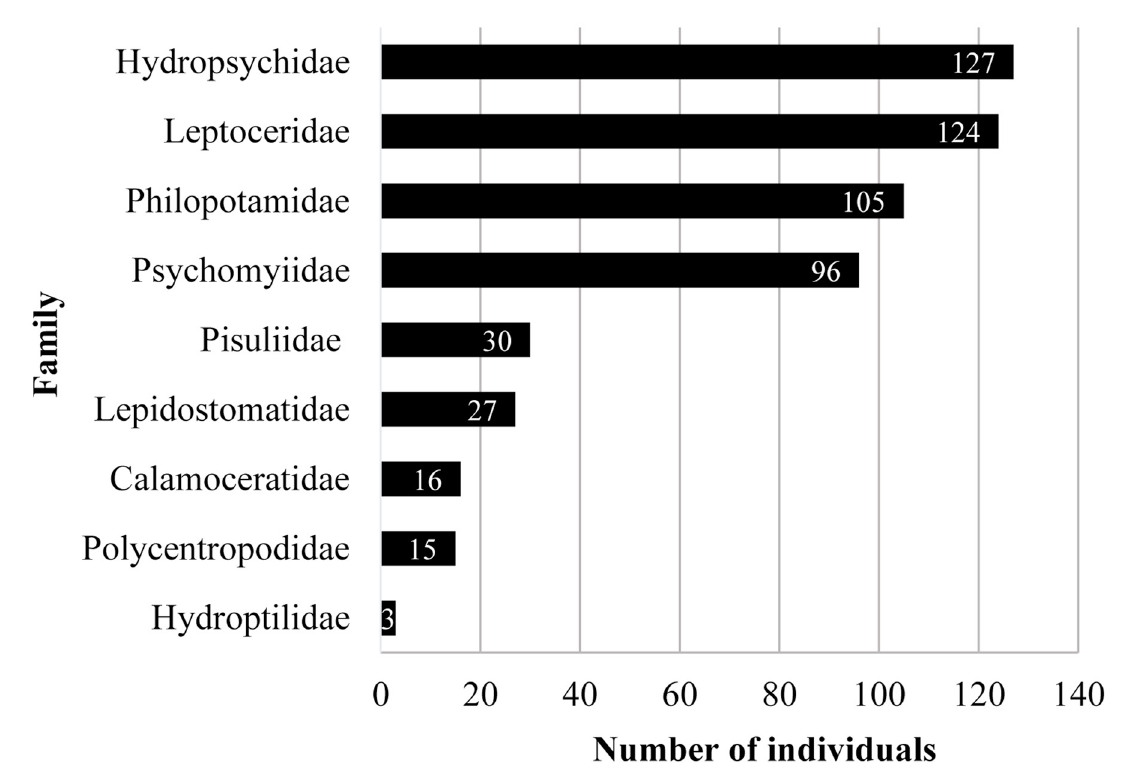
Fig. 2. Number of collected individuals per family from Malaise traps and light traps